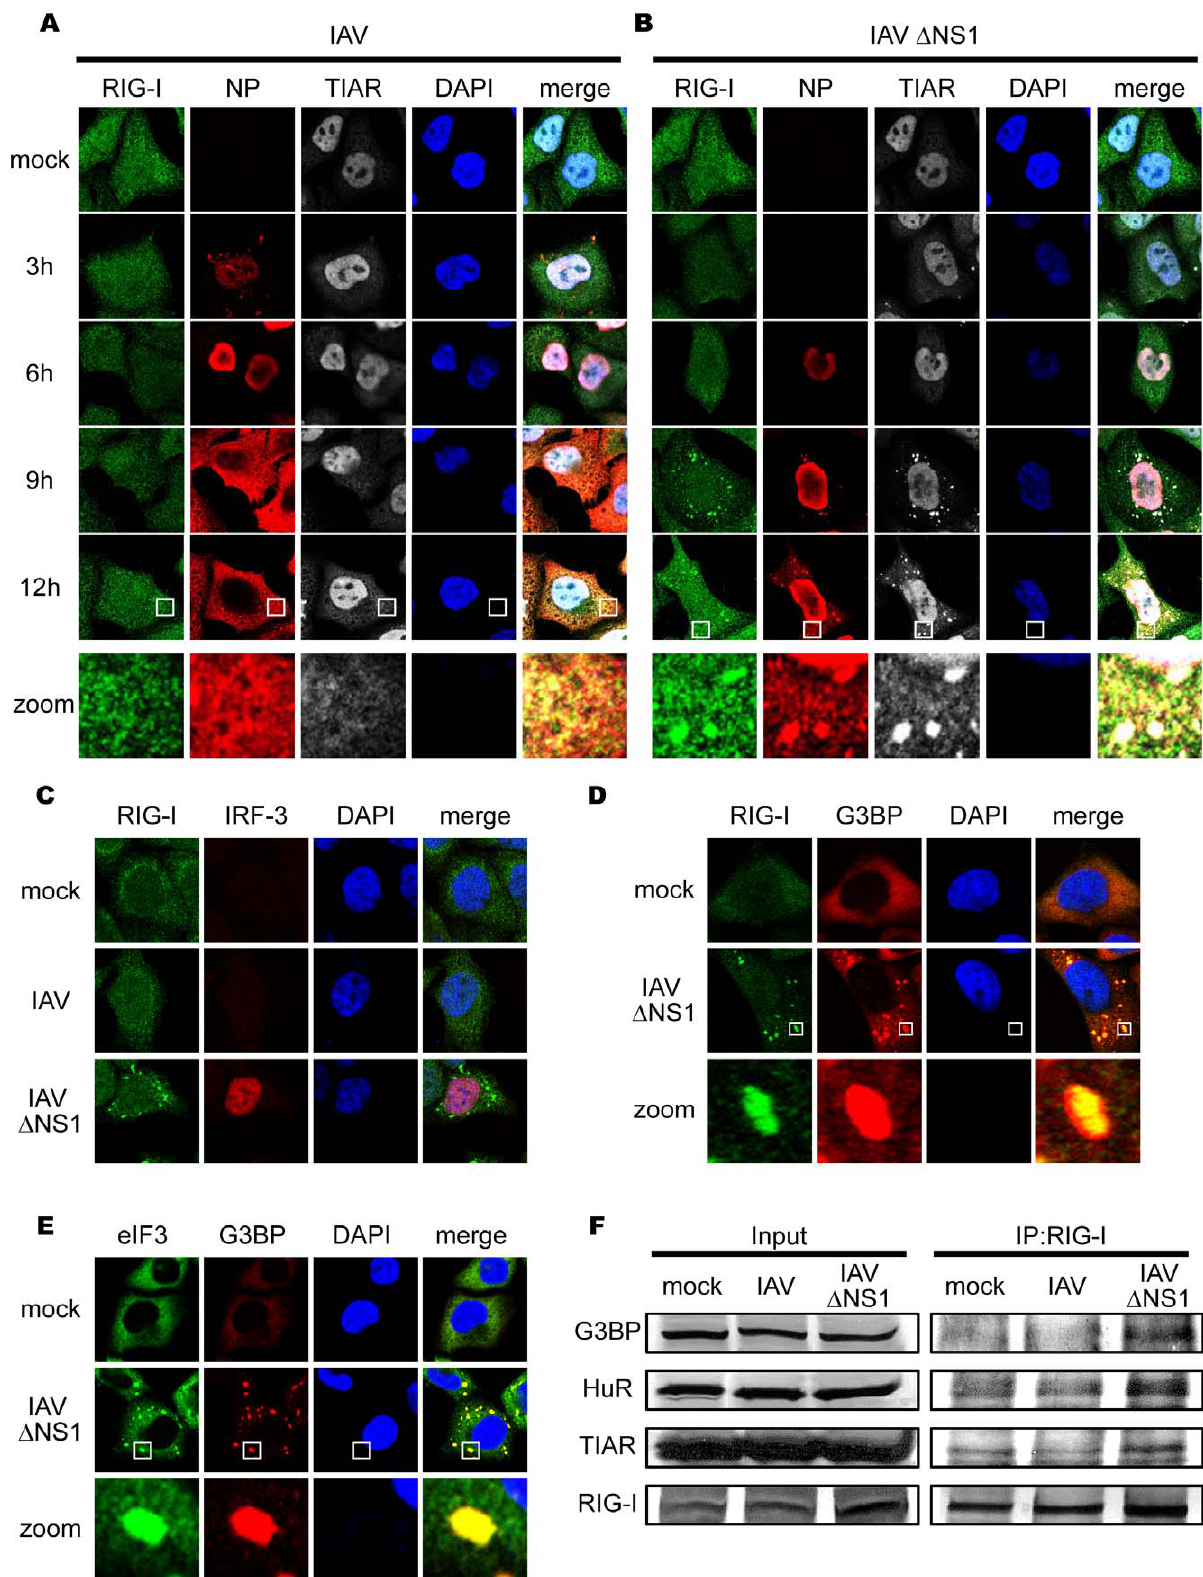
Figure 1. IAV infection causes a speckle-like distribution of RIG-I and stress granule markers. ( A–C ) HeLa cells were mock-treated or infected with IAV ( A ) or IAVA¨NS1 ( B ) for the indicated period, fixed, stained, and analyzed with confocal microscopy. The cells were stained with anti- RIG-I (RIG-I), anti-IAV nucleocapsid protein (NP), and anti-TIAR (TIAR) antibodies. Nuclei were stained with DAPI. At 9 h and 12 h after infection, the